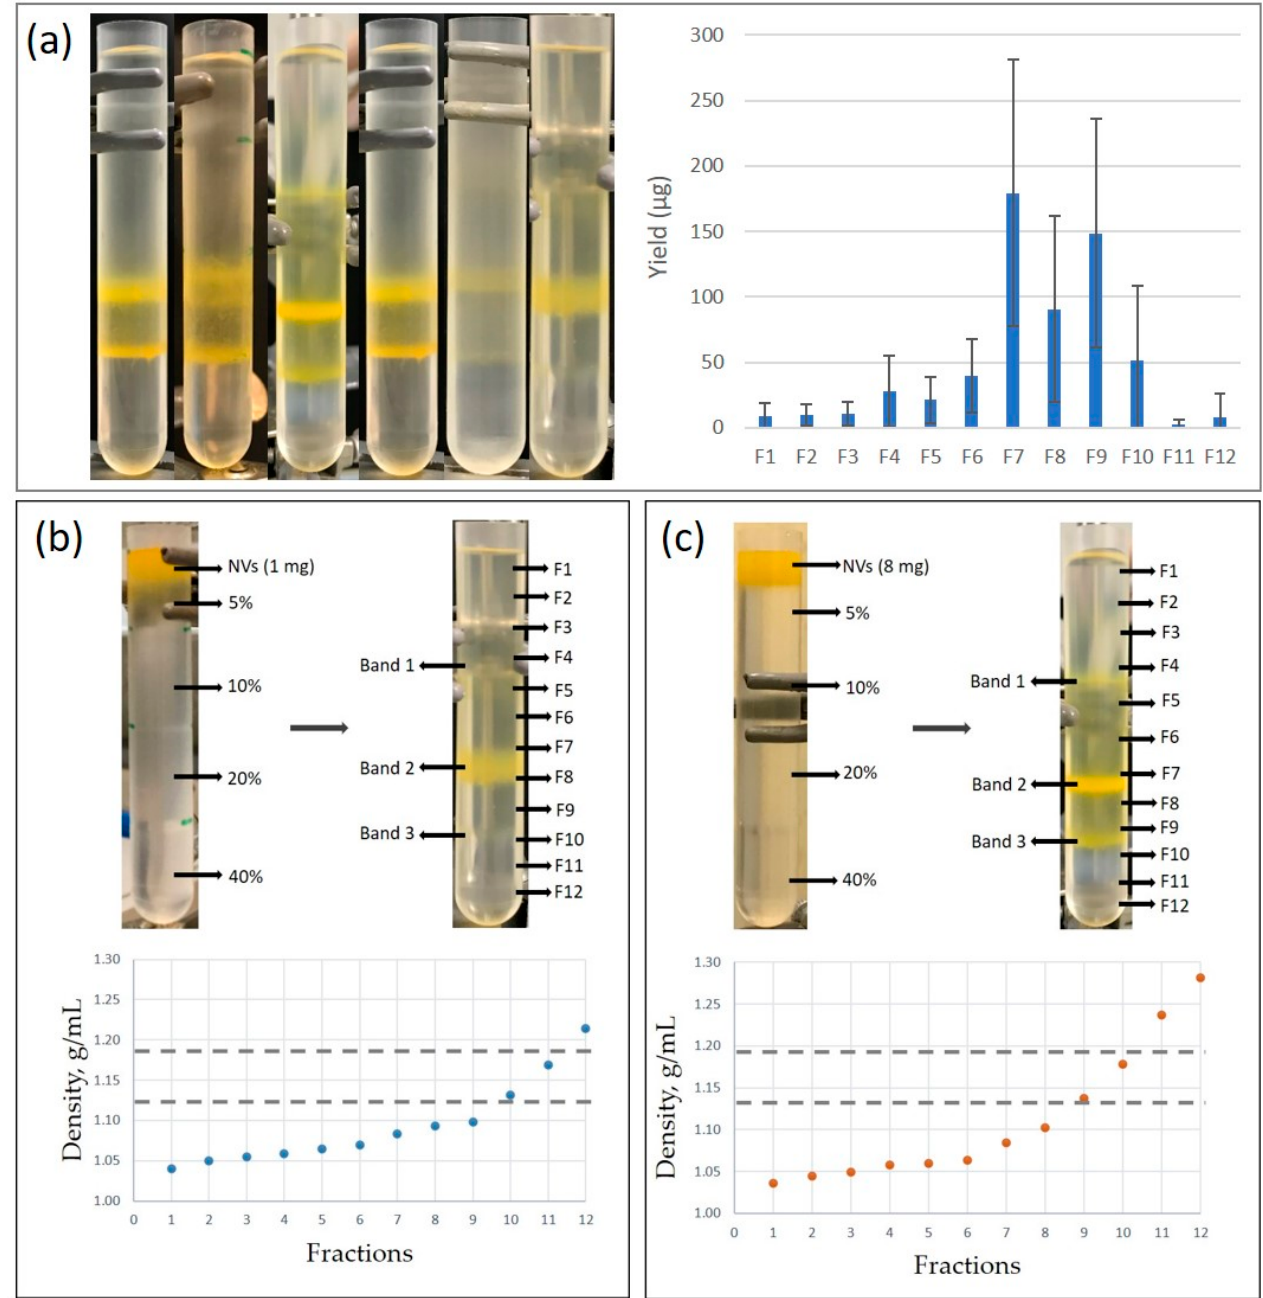
Figure 2. ( a ) Separation of nanovesicles (NVs) from different batches of tomatoes (Piccadilly cultivar) by iodixanol density gradient ultracentrifugation (gUC) (1 mg of NVs loaded, n = 6); graph on the right shows the average yields based on protein concentration in each fraction. ( b ) Iodixanol gUC of bulk tomato nanovesicles (NVs) without viruses, and ( c ) iodixanol gUC of bulk tomato NVs containing viral particles. Density curves show the densities calculated in each fraction. Horizontal dashed lines indicate the density range typical of mammalian extracellular vesicles [51].